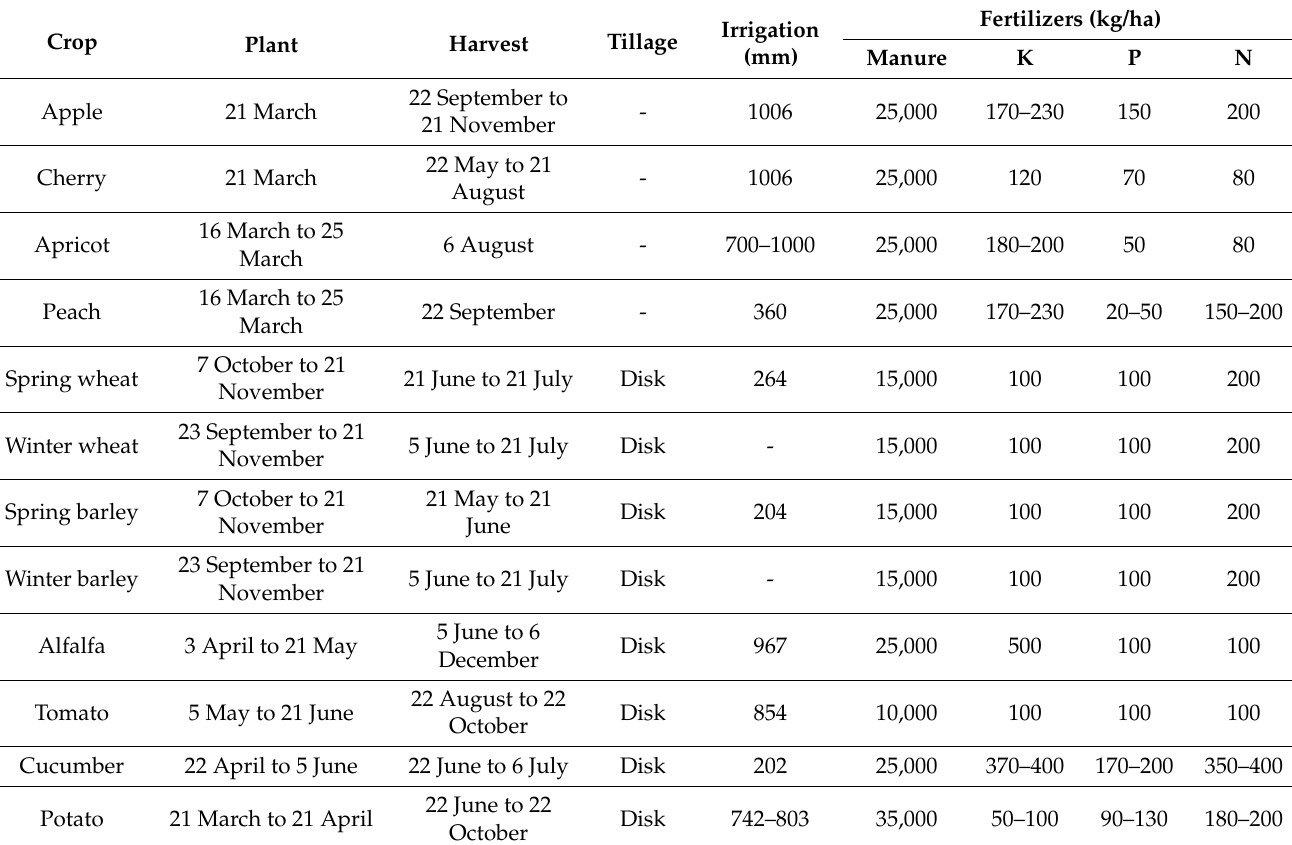
Table 1. Management data and standard fertilizer application in the Jajrood river